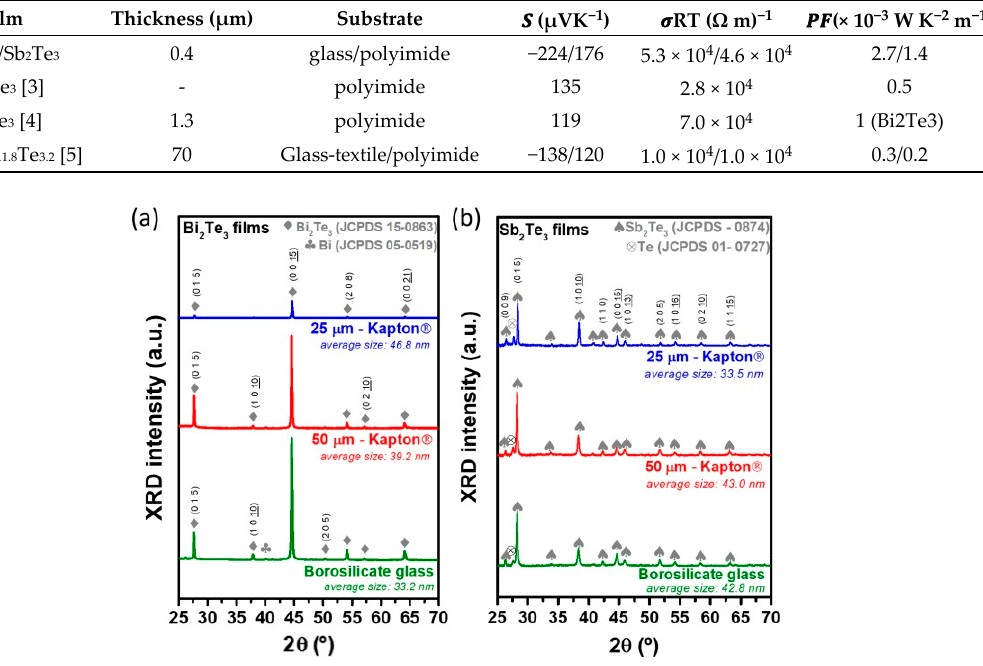
Figure 2. XRD patterns for ( a ) Bi 2 Te 3 and ( b ) Sb 2 Te 3 films deposited on the three substrates. Average NCs size is indicated for each film. The presence of Bi (for Bi 2 Te 3 films) and Te (for Sb 2 Te 3 films) diffraction peaks confirms that the films are Bi- and